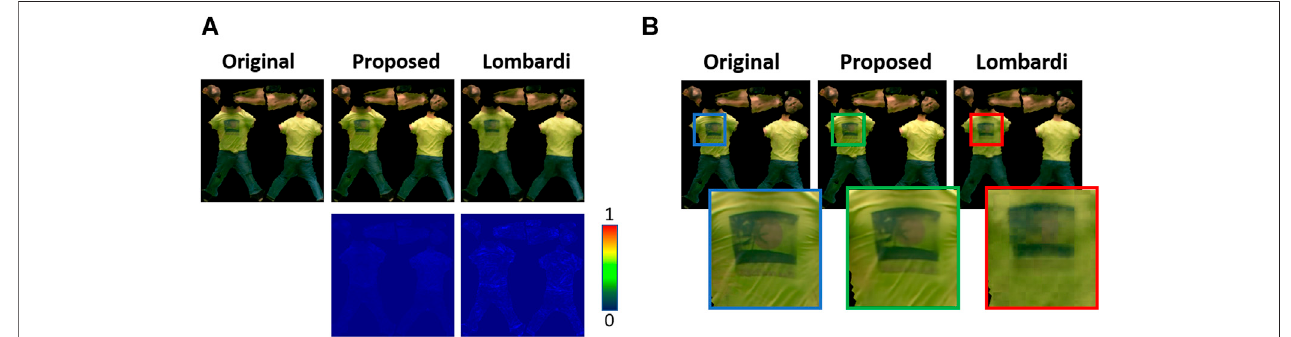
FIGURE 7 | Thomas appearance synthesis qualitative evaluation of Lombardi et al. (2018).